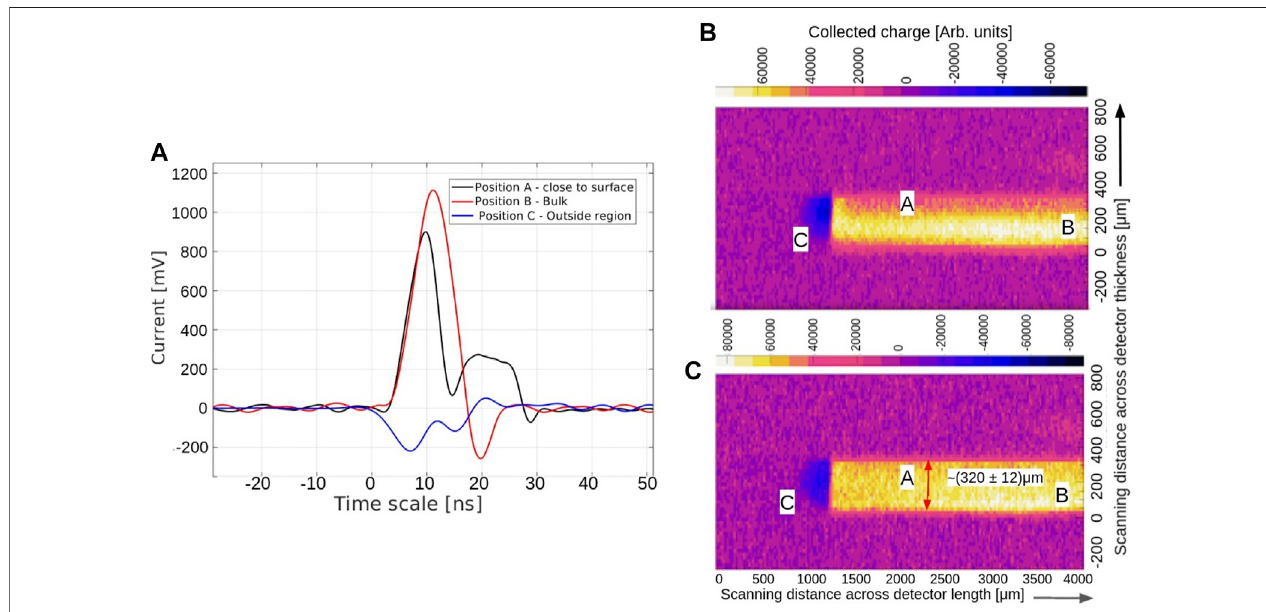
FIGURE 12 | (A) Signal waveforms readout when IR laser is projected at different positions across the edge of the detector. (B,C) showing the 2-dimensional collected charge mappings on integrating over 15 and 40 ns of the current signal, respectively, as the IR laser scans across the active thickness of the detector. The measurement was performed at a constant bias voltage of 120 V at room